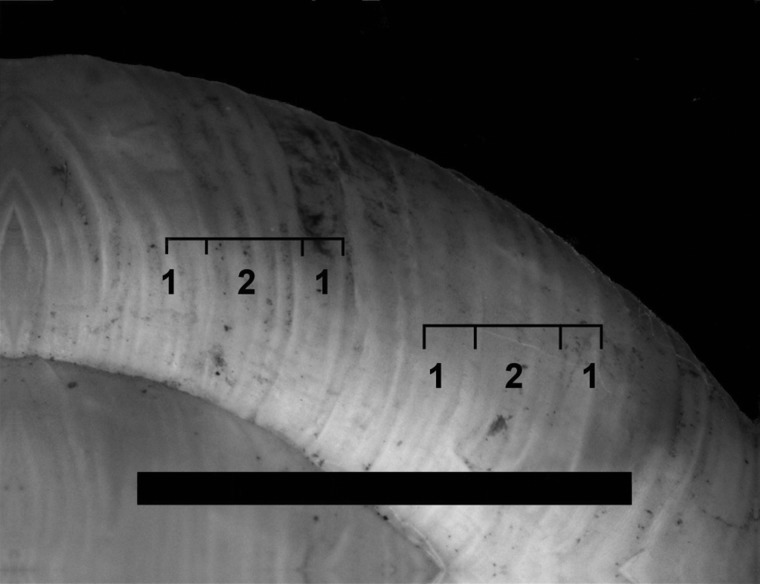
Characteristic riffle structures on the periostracum of Trochulus striolatus subspp., illustrated by an individual of the nominate subspecies (individual no. 4043, sample site no. 416); coarse ribs (1; spacing about 0.5 mm) are followed by narrow ones (2; spacing smaller than 0.25 mm). Scale bar = 5 mm.